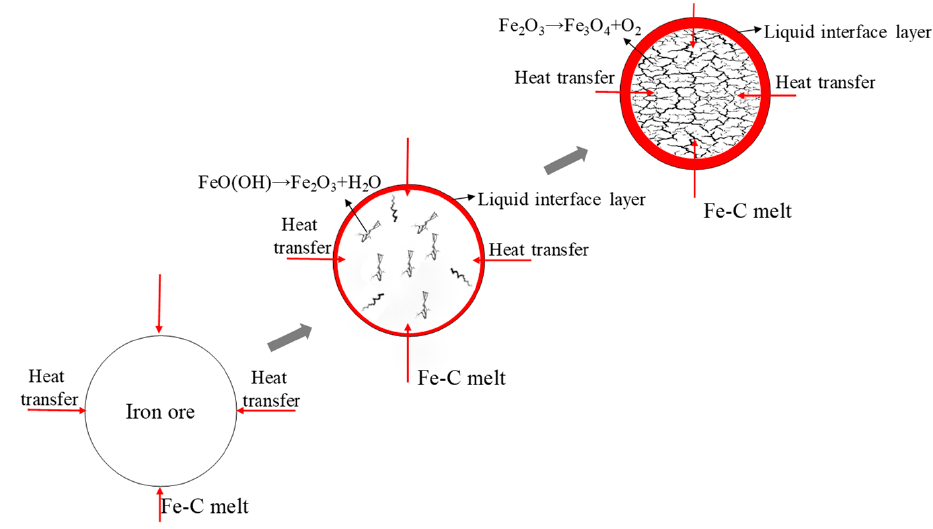
Figure 15. Crack formation mechanism of iron ore in Fe-C melt.